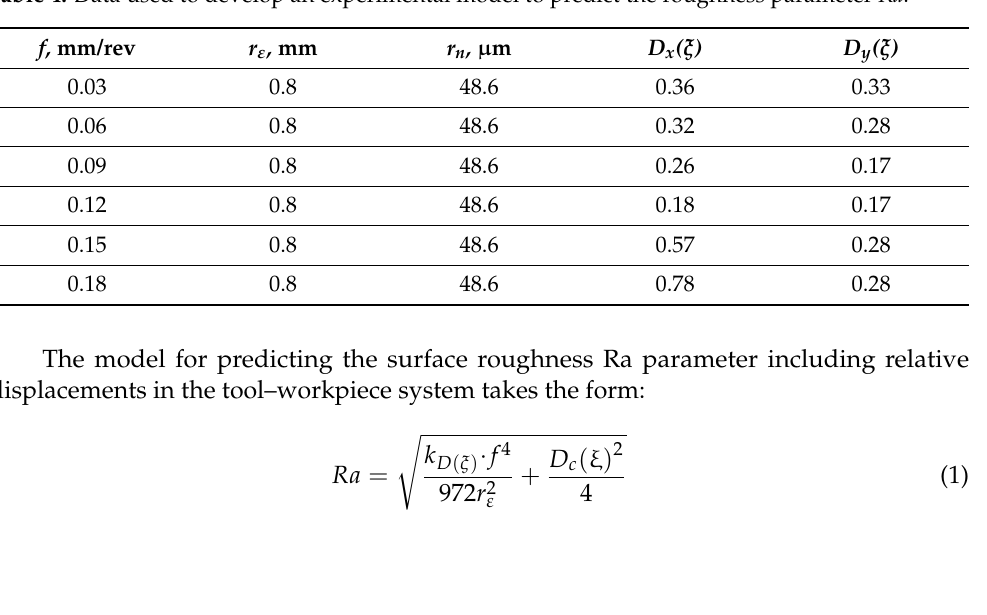
Figure 9. Examples of 3D and 2D surface topography, v c = 360 m/min, a p = 0.35: ( a ) f = 0.03 mm/rev; ( b ) f = 0.06 mm/rev; ( c ) f = 0.09 mm/rev; ( d ) f = 0.12 mm/rev; ( e ) f = 0.15 mm/rev; ( f ) f = 0.18 mm/rev; ( g ) f = 0.18 mm/rev; r n =29.6 µ m; ( h ) f = 0.18 mm/rev; r n = 7.7 µ m; ( i ) f = 0.18 mm/rev; r n = 48.6 µ m. Table 4. Data used to develop an experimental model to predict the roughness parameter Ra .